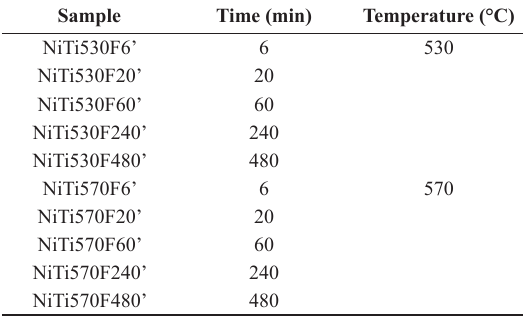
Table 1. Sample identification according to heat treatment